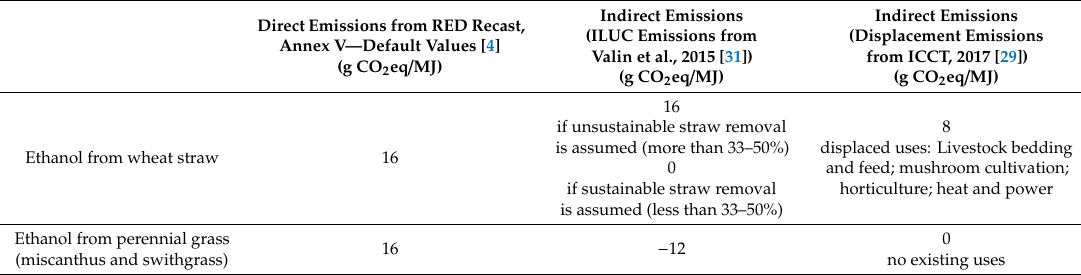
Table 2. Estimated greenhouse gas (GHG) emissions (direct and indirect) associated with cellulosic ethanol production from cereal straw and perennial